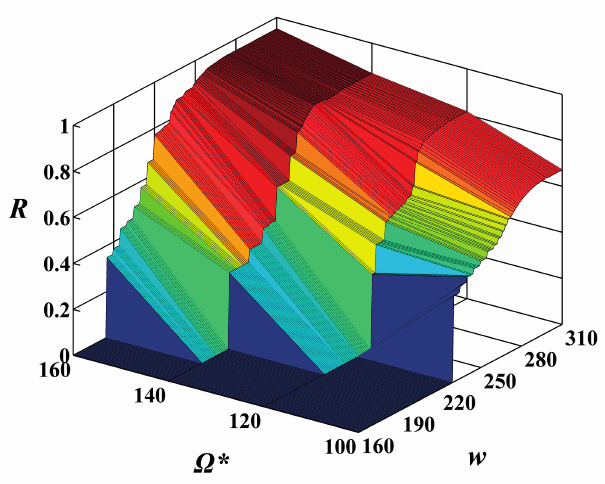
Figure 9. The values of reliability function R ( w * ) with alterations in the execution time w from 160 to 310 and in the given cost constraint Ω * from 100 to 160 under the given expected execution time w * =